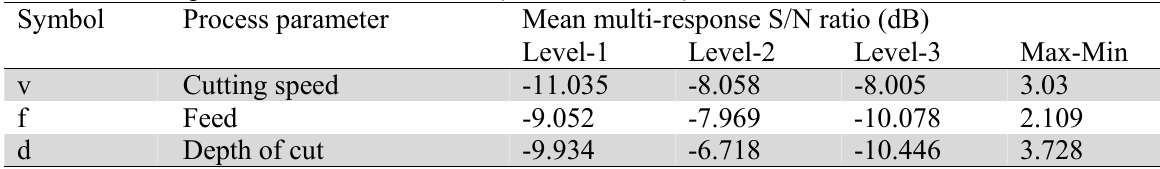
Total mean multi-response S/N ratio = -8.856 Mean multi-response S/N table for case-3 (w 1 = 5, w2 = 5)